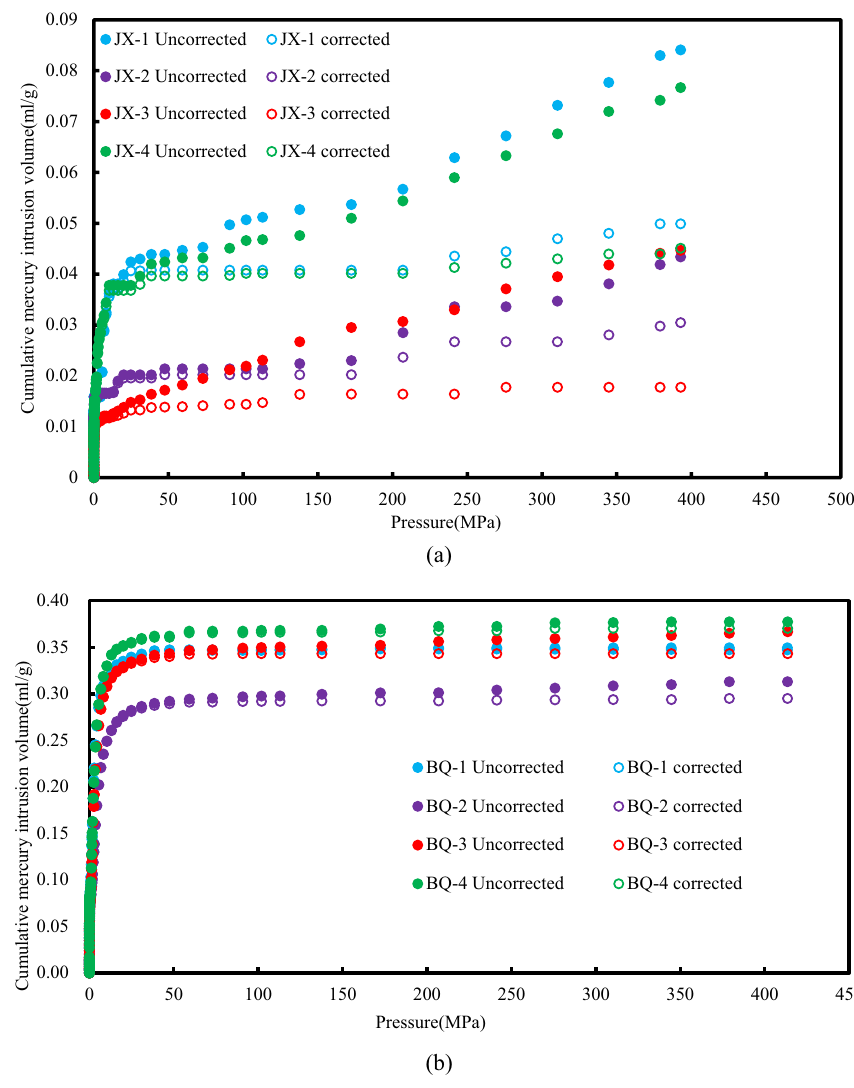
Figure 5. The cumulative mercury intrusion volume before and after